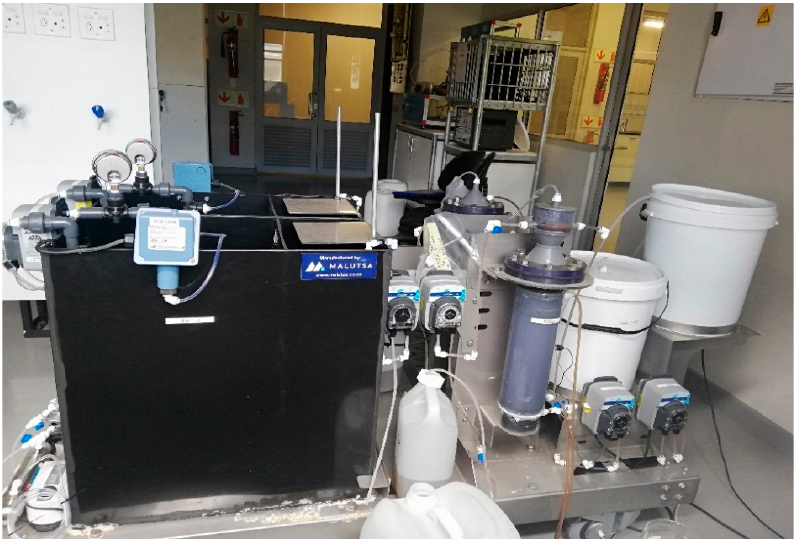
Figure 1. Poultry slaughterhouse wastewater (PSW) miniaturized lab-scale plant setup.